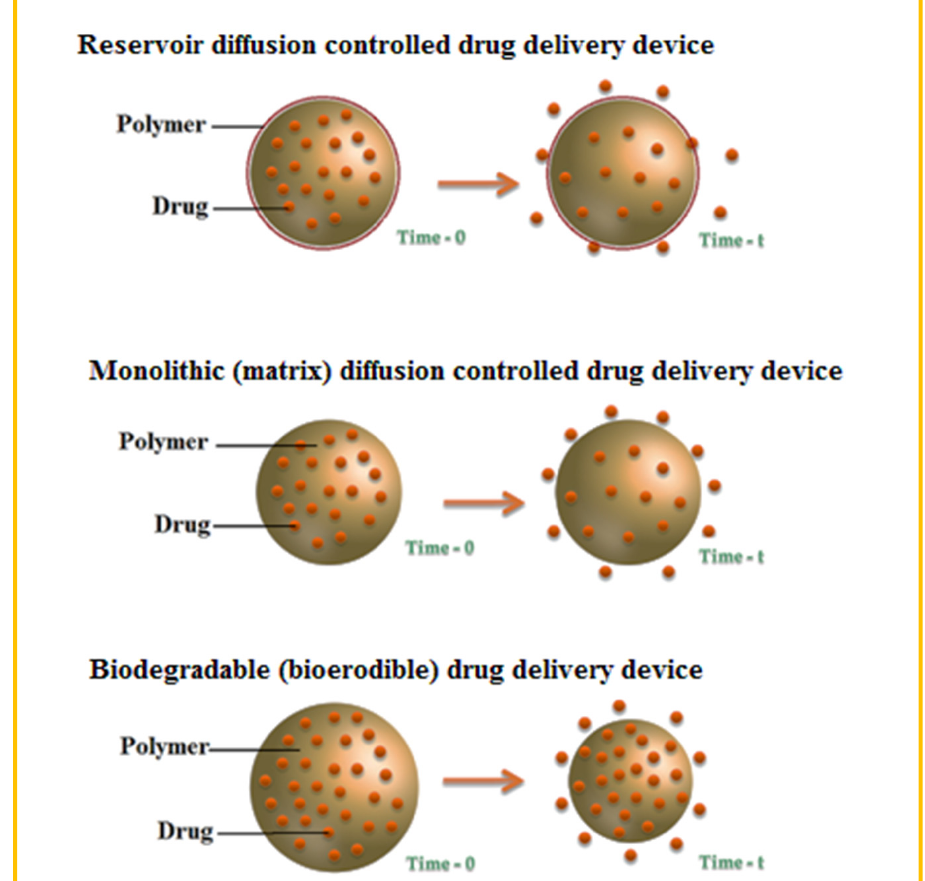
Figure 3. Schematic representation of reservoir diffusion-controlled drug delivery device, mono- lithic (matrix) diffusion-controlled drug delivery device, and biodegradable (bio-erodible) drug de- livery device.